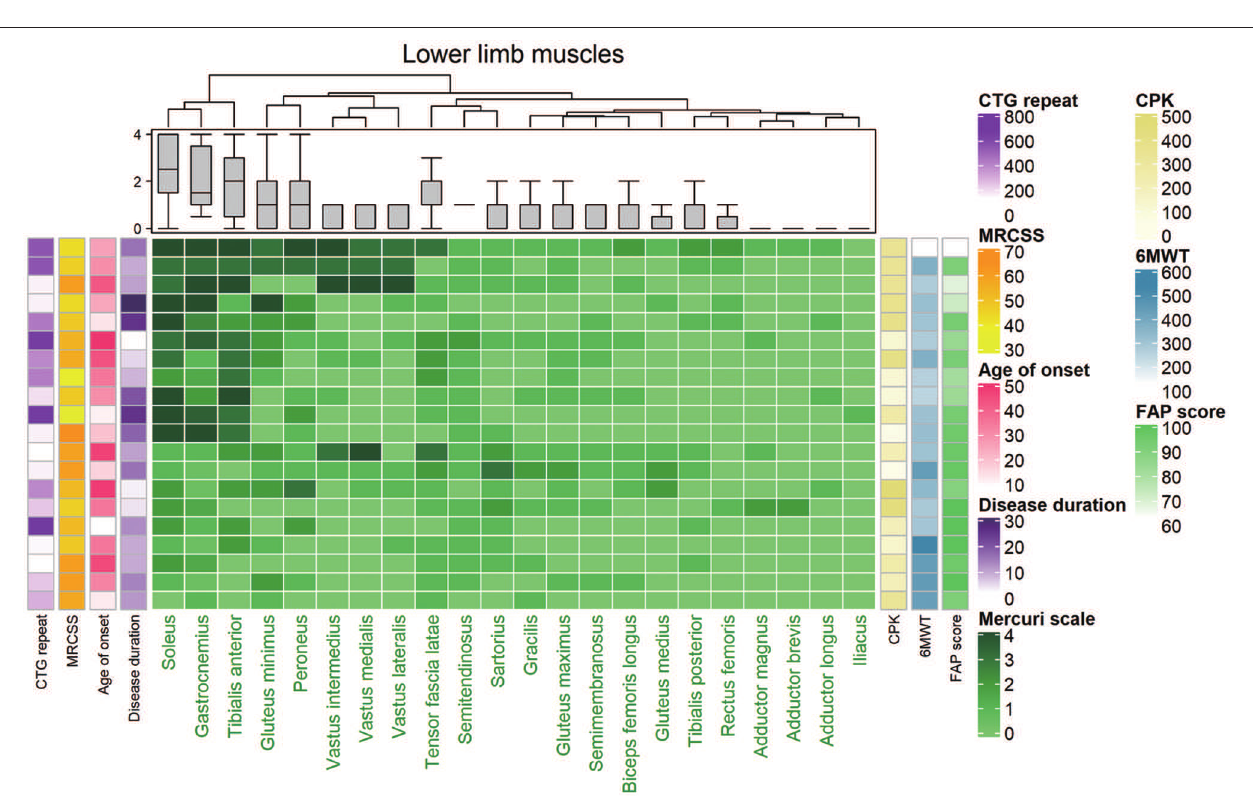
FIGURE 2 | Hierarchically clustered heat map of Mercuri scale ratings from magnetic resonance (MR) images from 20 patients with DM1. The map showed that the included patients could be divided into two distinct groups with mild fatty replacement and with moderate/severe fatty replacement. Each low corresponds to one patient, and they are hierarchically clustered based solely on MR imaging data (using the Mercuri scale). Each column in the heat map corresponds to one muscle, in descending order from the most to least degenerated. A gray-green-midnight green gradient in the heat map indicates increasing fatty substitution (legend at the bottom). The five columns at the left of the heat map denote individual clinical features (not used in the hierarchical clustering algorithm): CTG repeat, CPK, MRCSS, age of onset, and duration of disease, color-coded as indicated in the legend on the right. The three columns at the right of the heat map denote CPK, 6MWT, and FAP score (not used in the hierarchical clustering algorithm) individual clinical features (not used in the hierarchical clustering algorithm), color-coded as indicated in the legend on the right. MRCSS, Medical Research Council sum score; 6MWT, 6 minute walk